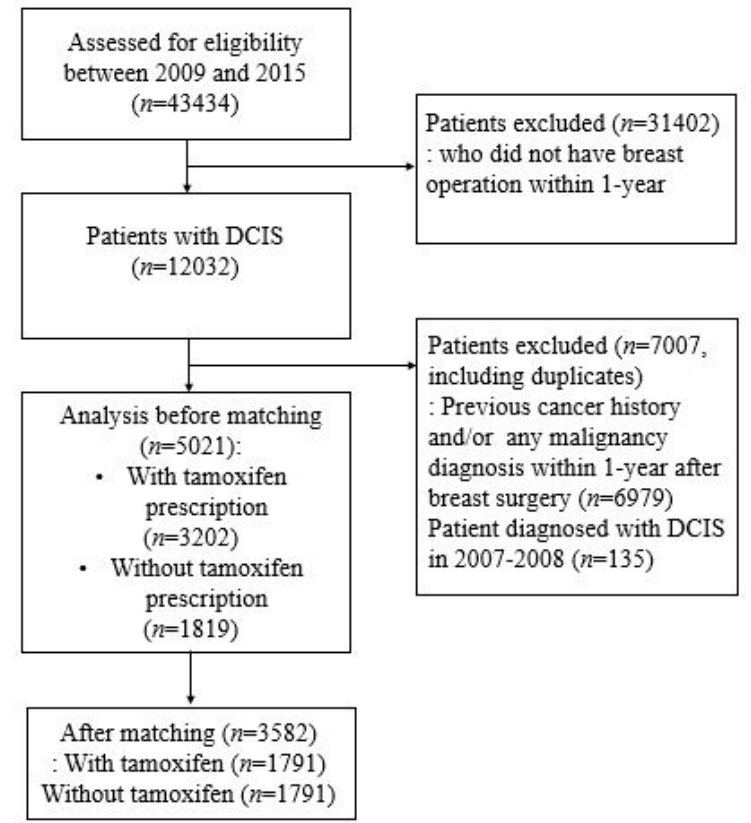
Figure 1. Consort diagram of study design.